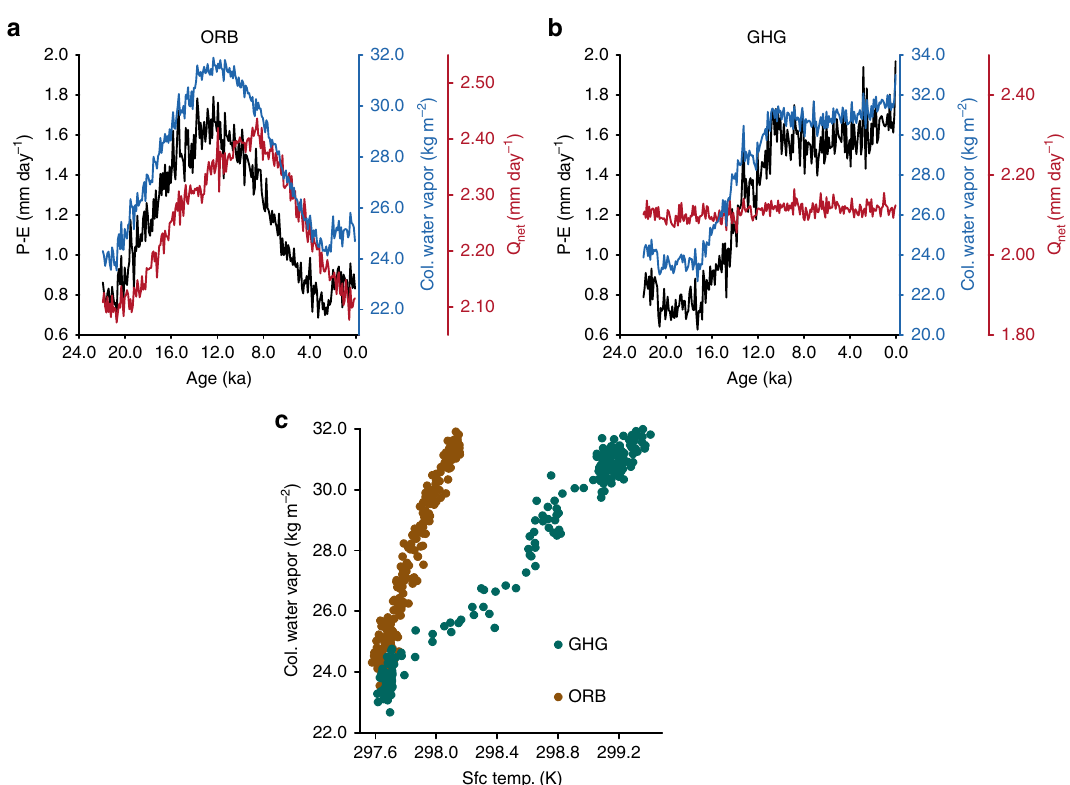
Fig. 3 Monsoon response to individual forcings. The time series of P (cid:3) E (black), total column water vapor, CWV (blue) and net downward energy fl ux at the top of the atmosphere, Q (red) for the a orbit-only simulation (ORB), and b greenhouse gas-only simulation (GHG). c A scatter plot between surface net temperature over the region (0 (cid:1) – 29 (cid:1) N; 50 (cid:1) – 70 (cid:1) E) and CWV over India (10 (cid:1) – 29 (cid:1) N; 70 (cid:1) – 85 (cid:1) E) for the ORB (brown), and GHG (green)